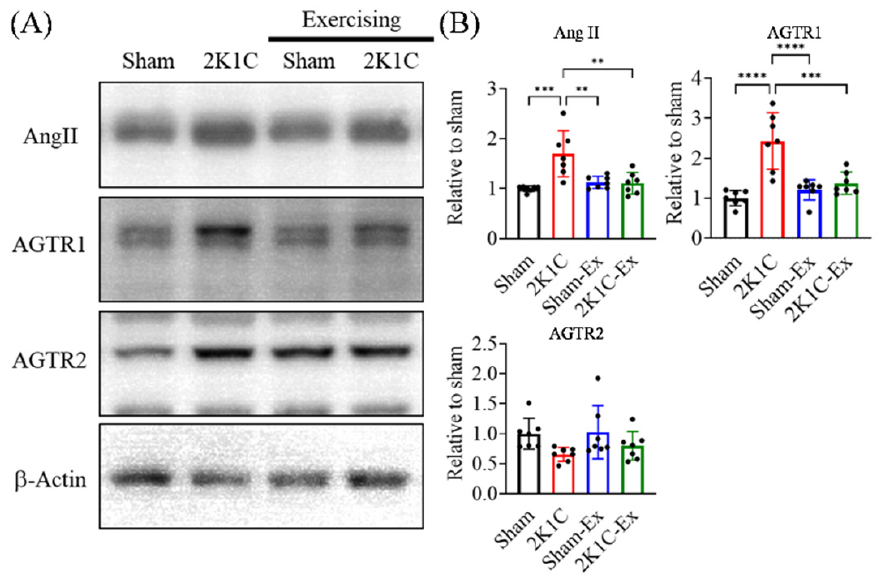
Figure 5. Exercise downregulates the 2K1C-hypertensive mouse model hippocampus RAS. ( A ) Representative immunoblots for each group of hippocampus tissue of the mice. ( B ) The quantitative result for protein level of Ang II, Angiotensinogen type I receptor (AGTR1), and Angiotensinogen type II receptor (AGTR2). The statistical analysis was performed by one-way ANOVA and Holm- Sidak’s multiple comparisons. The averaged data and s.d. are plotted. The sample sizes are seven for each group. **: p < 0.01, ***: p < 0.001, ****: p < 0.0001.